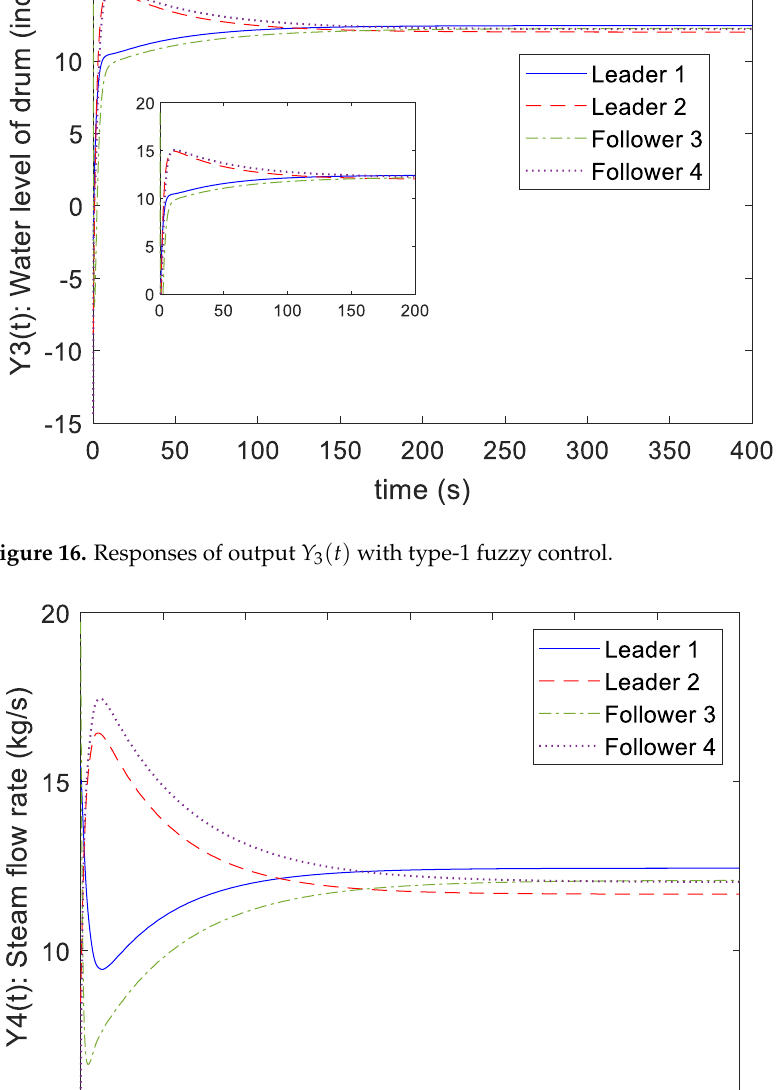
Figure 17. Responses of output Y ( t ) with type-1 fuzzy control.